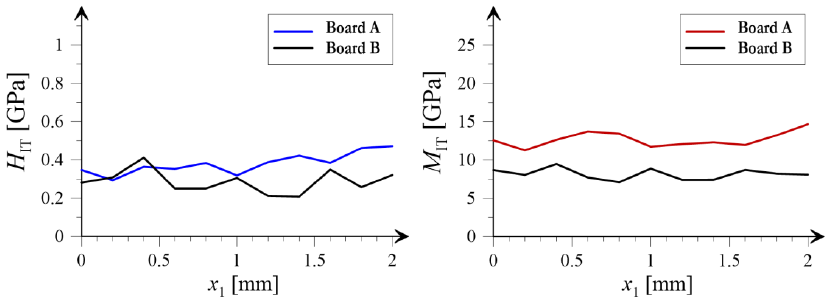
Figure 13. Average values of hardness ( H IT ) and indentation modulus ( M IT ) in the x 2 direction.